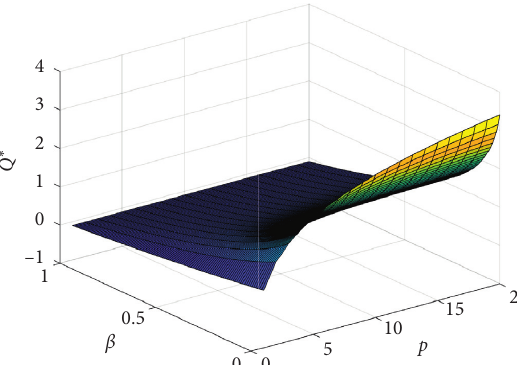
Figure 6: Effect of risk level β and wholesale price w on the optimal inventory quantity Q ∗ under RMI mode with stochastic demand in the water supply chain.